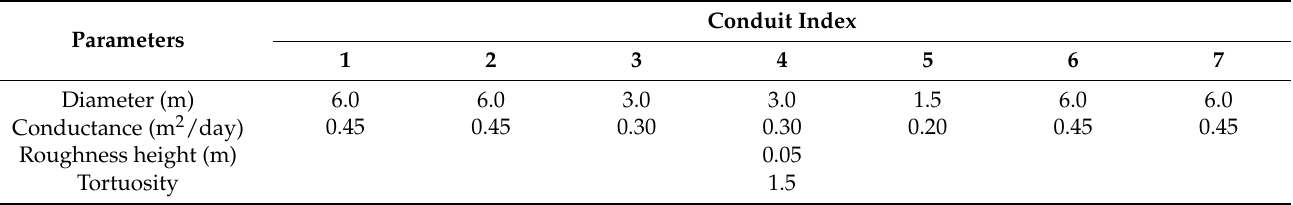
The calibrated values of diameter, conductance, roughness height, tortuosity for each